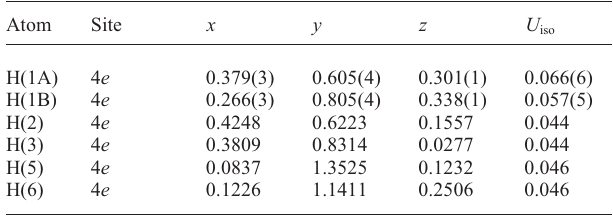
Table 2. Atomic coordinates and displacement parameters (in Å 2 ) .